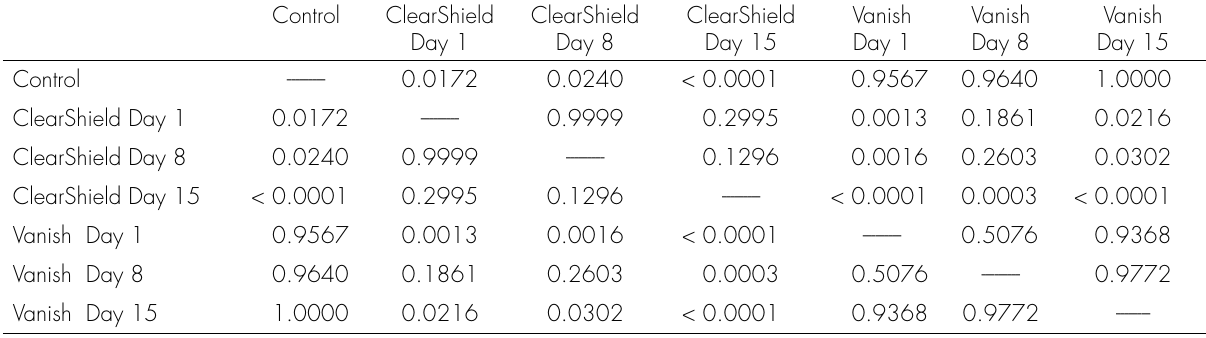
Table II. p -value of 2-way ANOVA comparing shear bond strength of experimental groups.